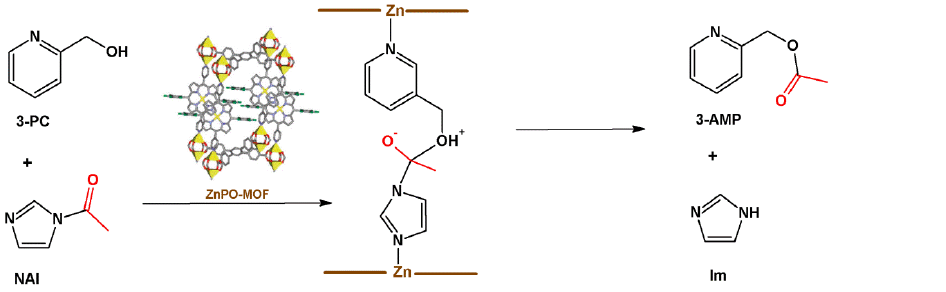
Figure 12. Acyl transfer from N-acetylimidazol (NAI) to 3-pyridylcarbinol catalyzed by ZnPO-MOF. In the MOF structure, zinc atoms are represented in yellow, oxygen in red, nitrogen in blue, fluorine in green, and carbon in grey. Reprinted (adapted) with permission from [124]. Copyright (2009) American Chemical